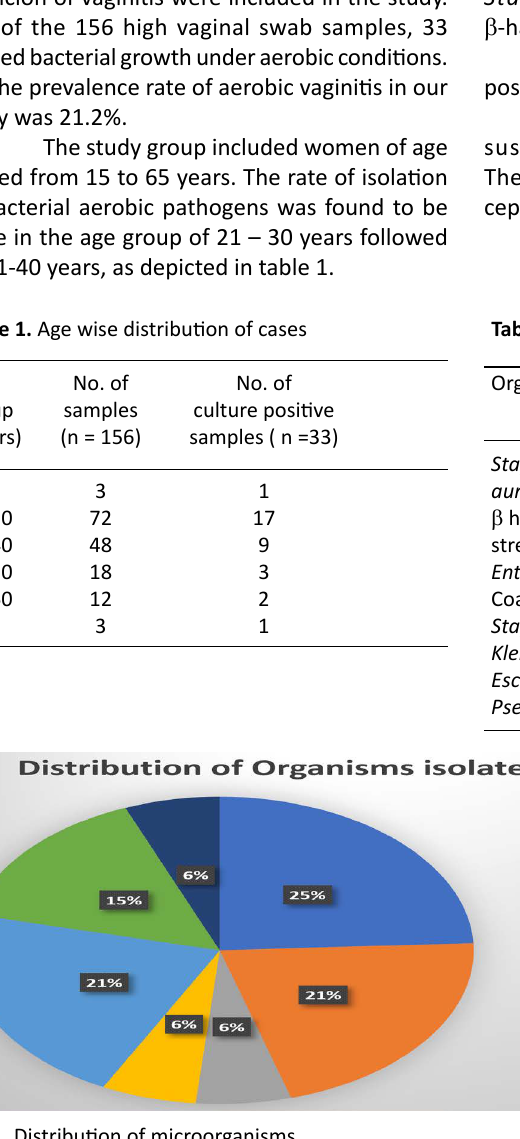
Fig. 1. Distribution of